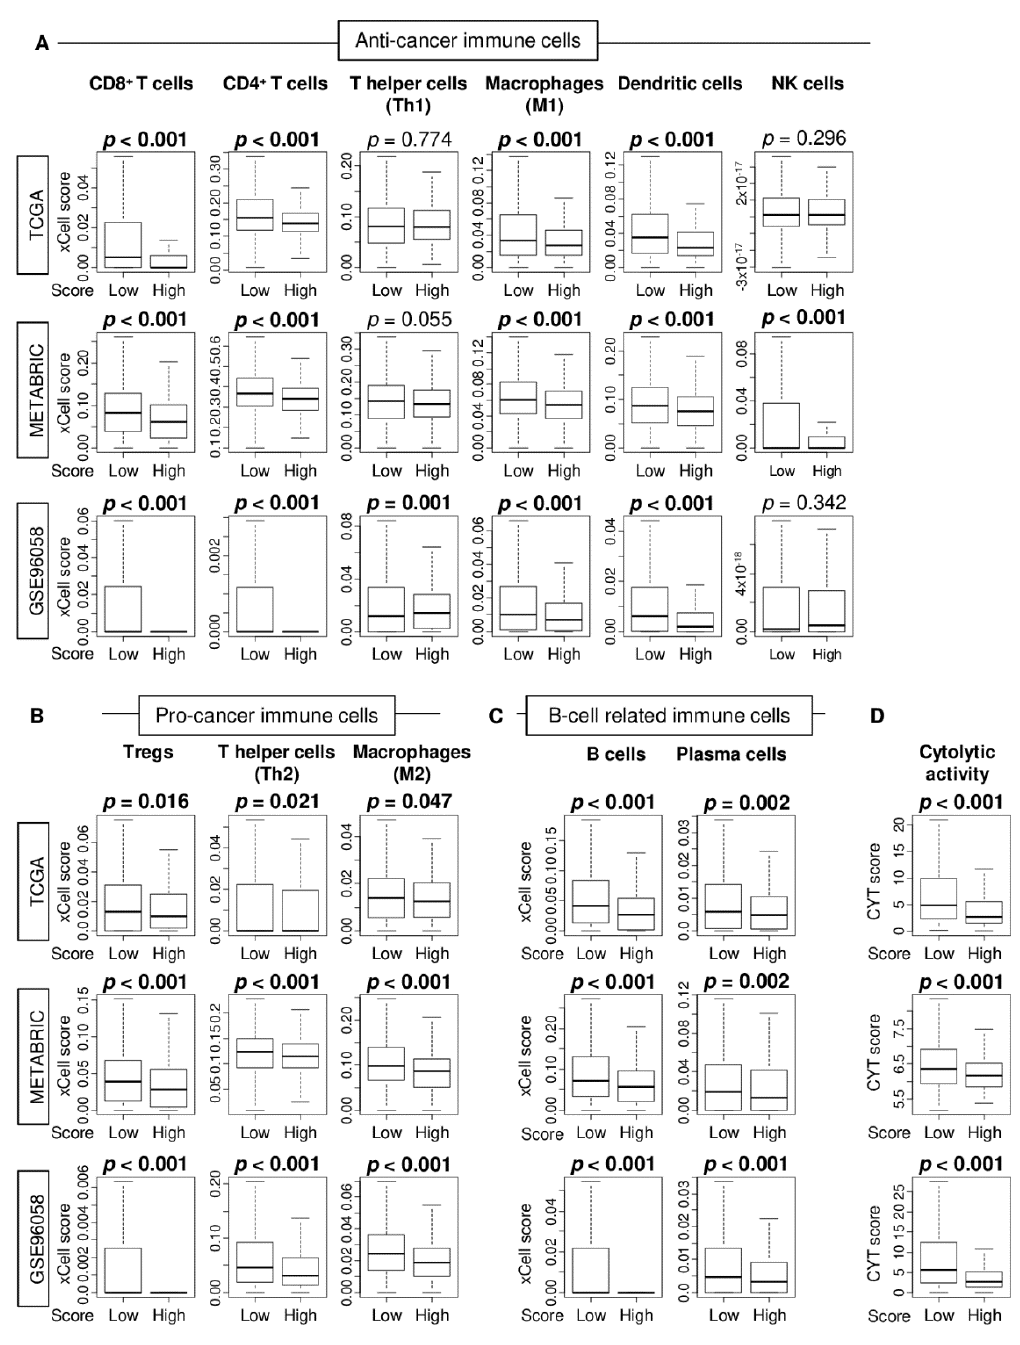
Figure 4. Association of the estrogen response early score and infiltrating immune cells in the estrogen receptor (ER)-positive / human epidermal receptor (HER2)-negative breast cancer. Boxplots of the comparison with a fraction of ( A ) anti-cancer immune cells (CD8 + T cells, CD4 + T cells, T helper type 1 (Th1) cells, M1 macrophages, dendritic cells, and NK cells), ( B ) pro-cancer immune cells (regulatory T cells [Tregs], T helper type 2 (Th2) cells, and M2 macrophages), and ( C ) B cells and plasma cells, as well as ( D ) the cytolytic activity score by low and high estrogen response early score group in the TCGA, METABRIC, and GSE96058 cohorts. p -value was calculated by one-way ANOVA test.